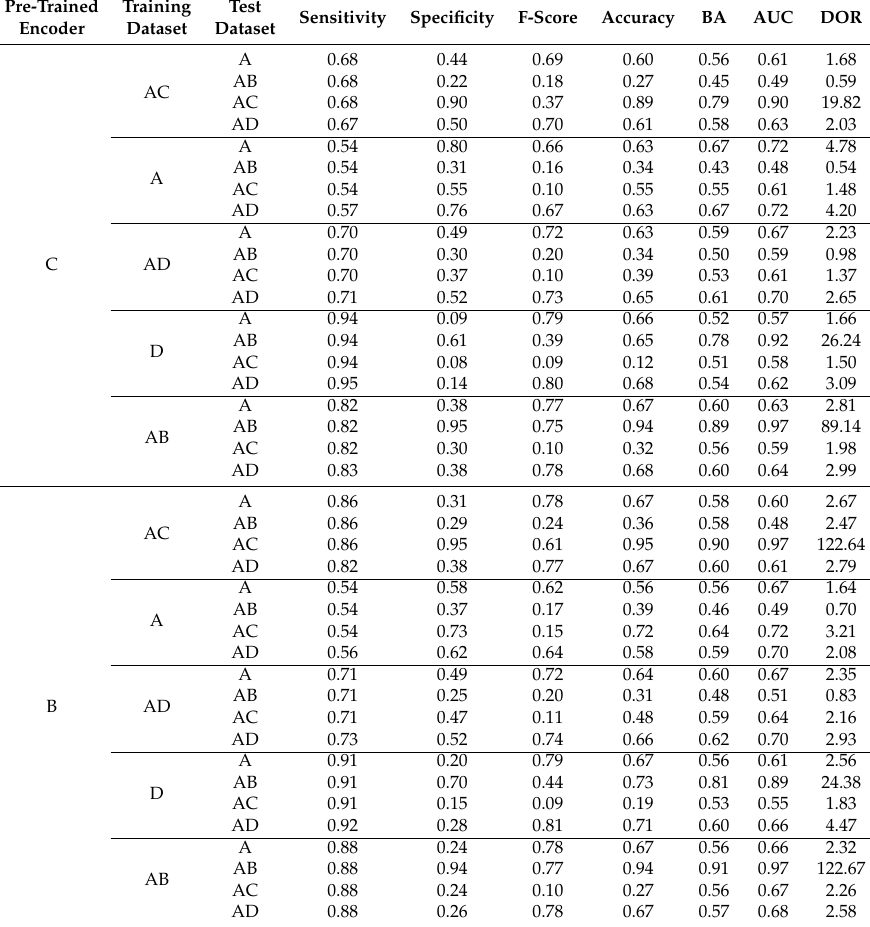
Table A2. Results obtained training a ResNet-18 model. Dataset naming follows Table 1. Pre-Trained